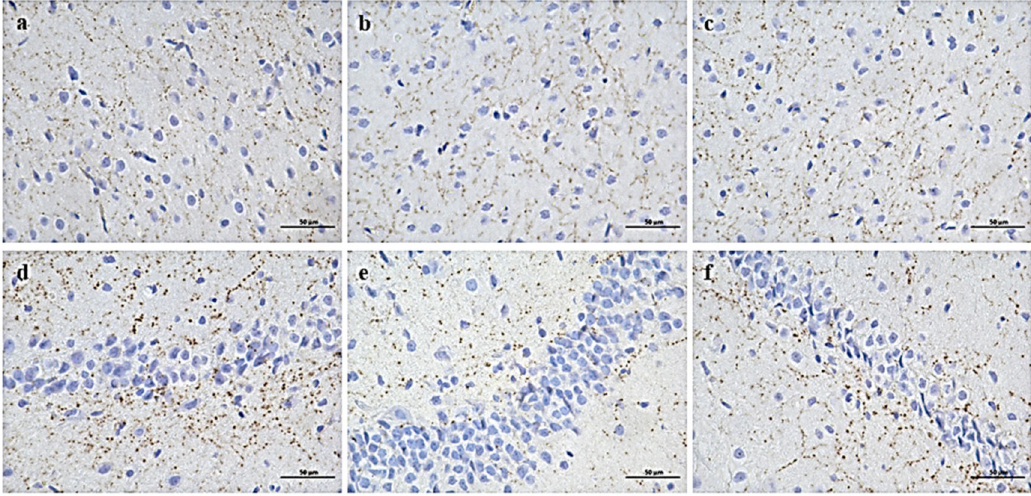
Figure 8. Expression of TPH2 in prefrontal cortex ( a – c ) and hippocampus ( d – f ) of three groups of